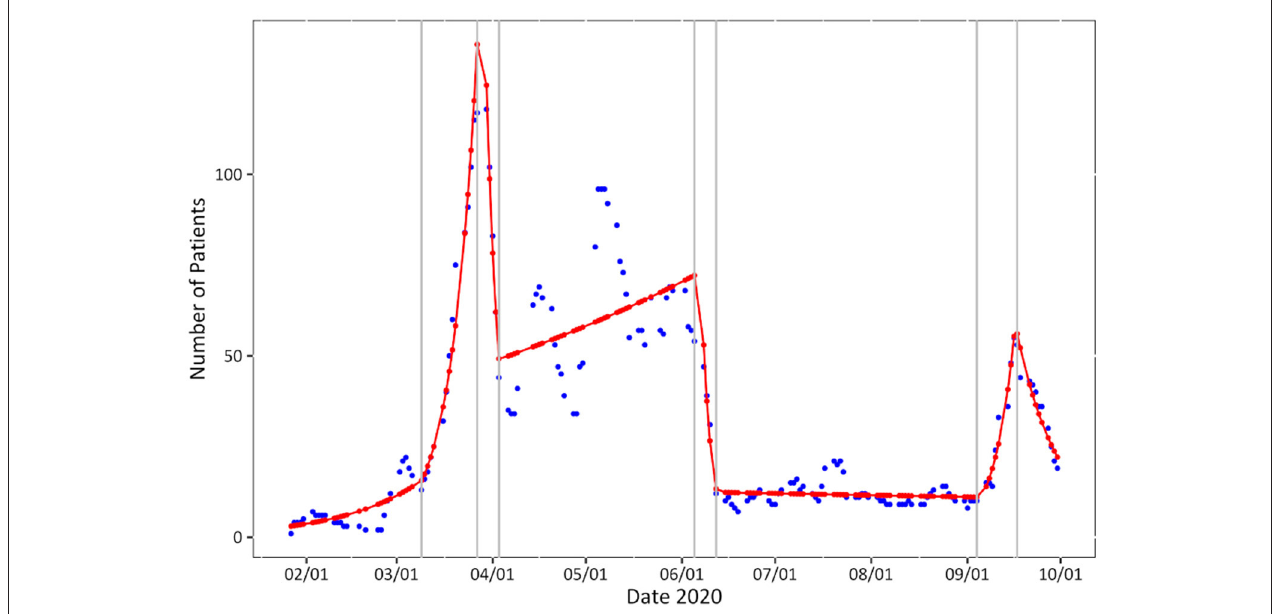
FIGURE 1 | Patient numbers over time. Seven-day moving average of daily patient numbers (blue), negative binomial model (red) with breakpoints (gray).